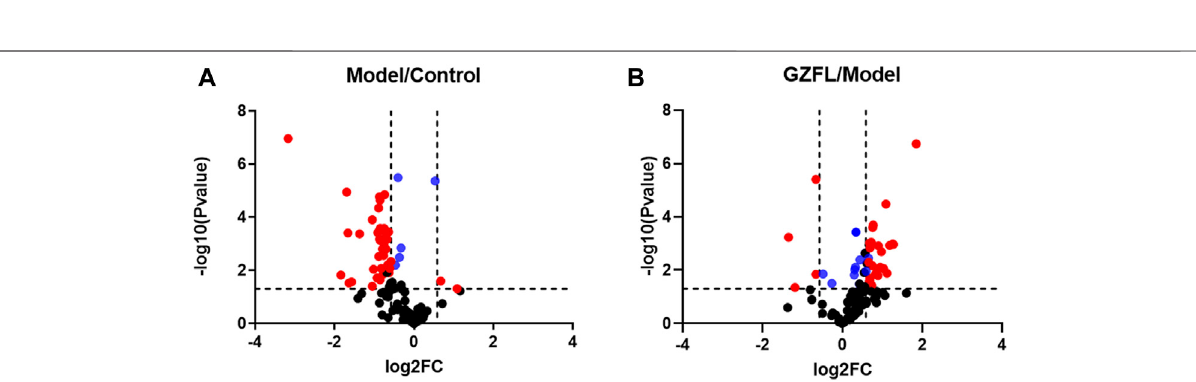
Frontiers in Pharmacology |